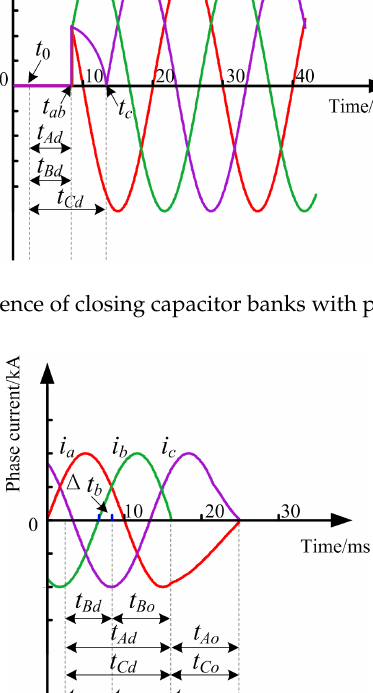
Figure 5. Sequence of opening capacitor banks with phase selection.